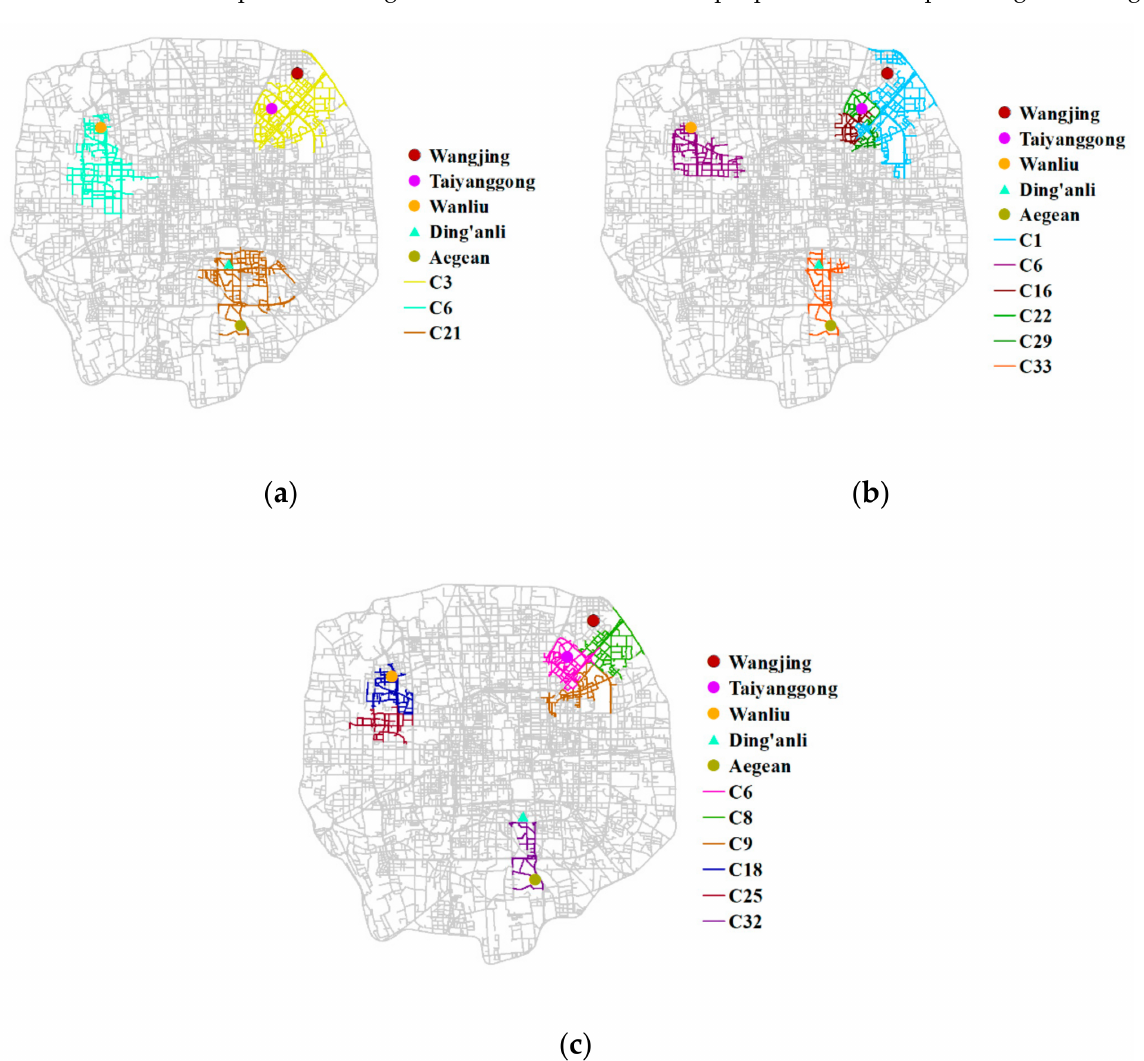
Figure 16. Some communities identified by EACO during evening rush hours: ( a ) 16:00–17:00; ( b ) 17:00–18:00; ( c )